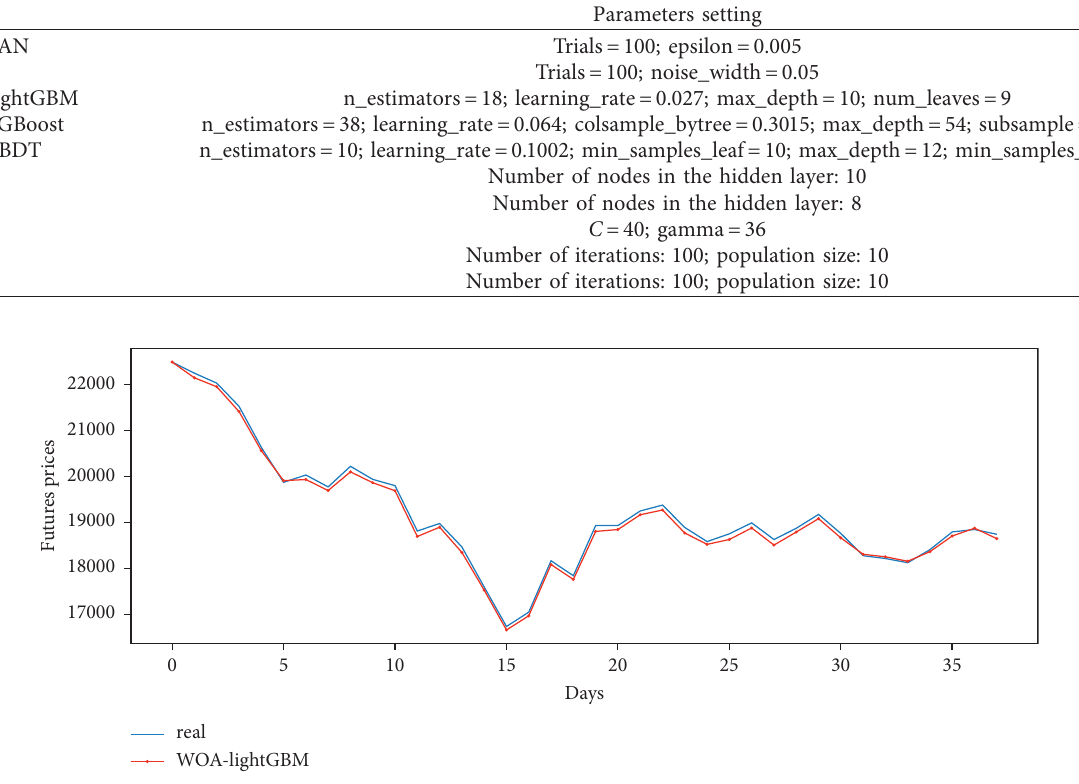
Figure 3: Preliminary fitting curve of WOA-LightGBM